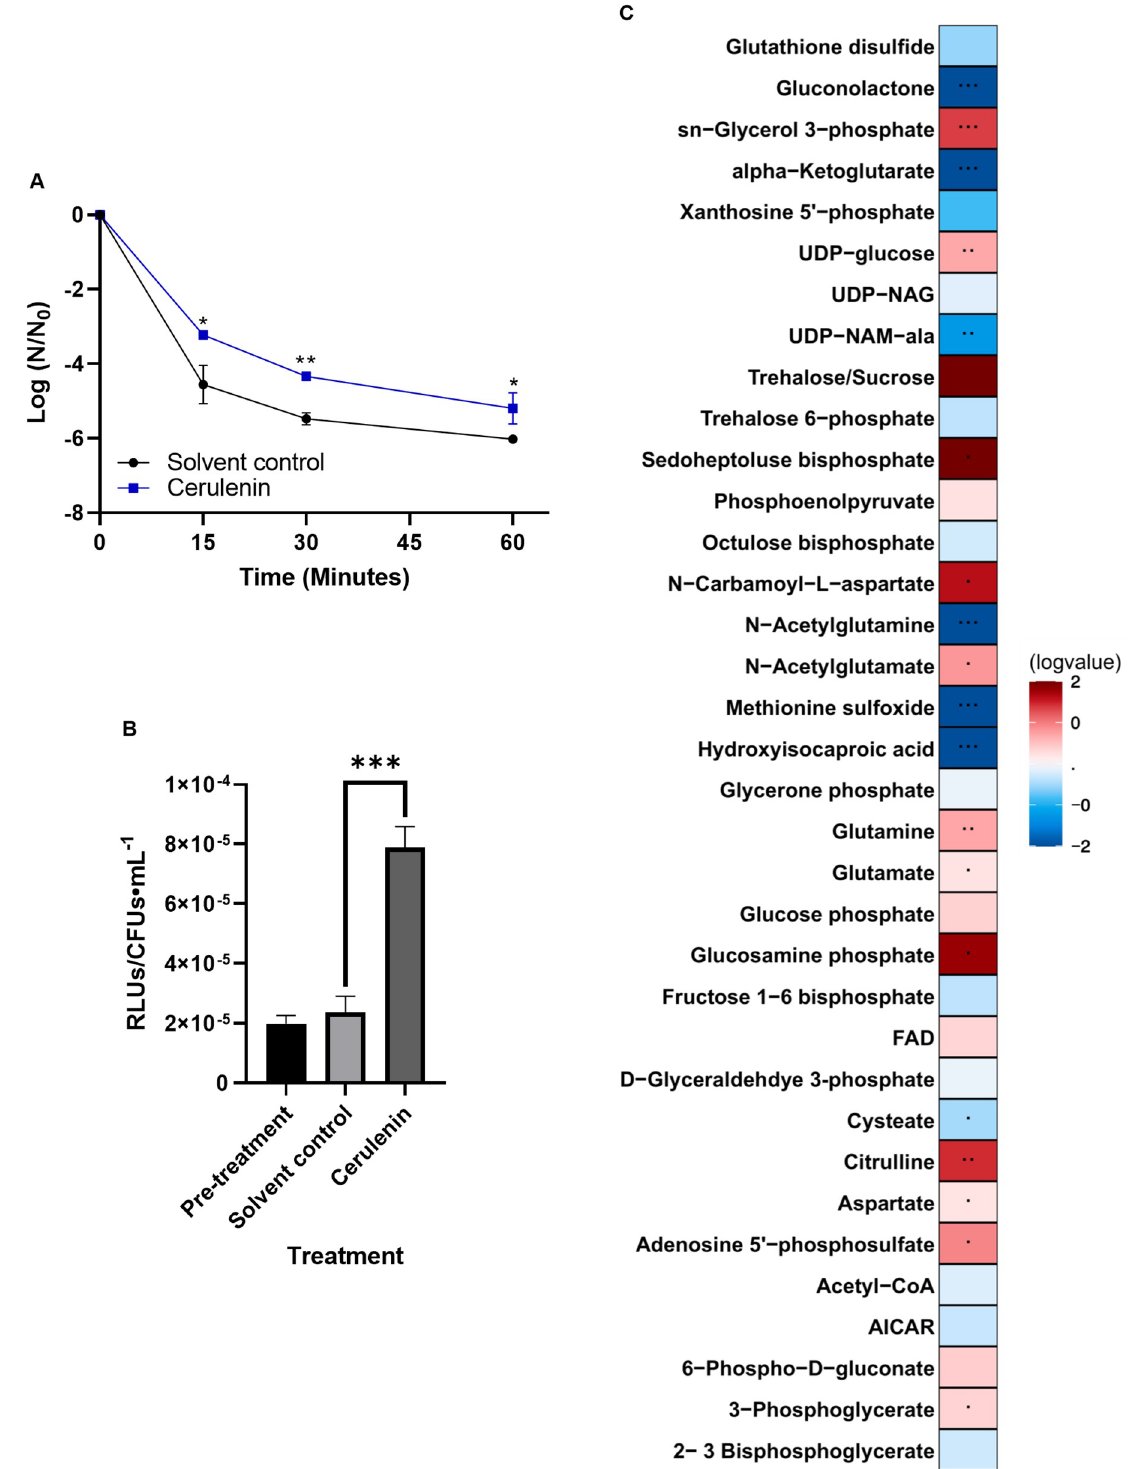
Fig 4. Cerulenin-treated cells have increased tolerance to daptomycin and an altered metabolic profile. (A) Cells were grown to early exponential phase, treated with cerulenin or solvent control, washed with 1x PBS, and then subjected to treatment with 30 μ g/mL daptomycin. Shown are the average log ratios of survivors ± standard deviations for n = 3 replicates. � P = 0.05–0.01; �� P = 0.01–0.001; exact P -values are found in S4 Table. (B) ATP levels of pre-treated, solvent-treated and cerulenin-treated cells were measured using the